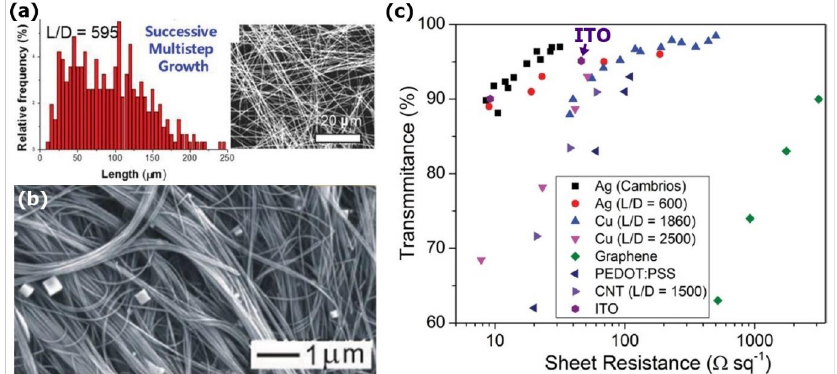
Figure 4. ( a ) Polydisperse size distribution of a metal nanowire made from Cu. ( b ) Scanning electron micrograph of a thin film of a random Cu nanowire mesh. ( c ) Performance of Cu and Ag nanowires